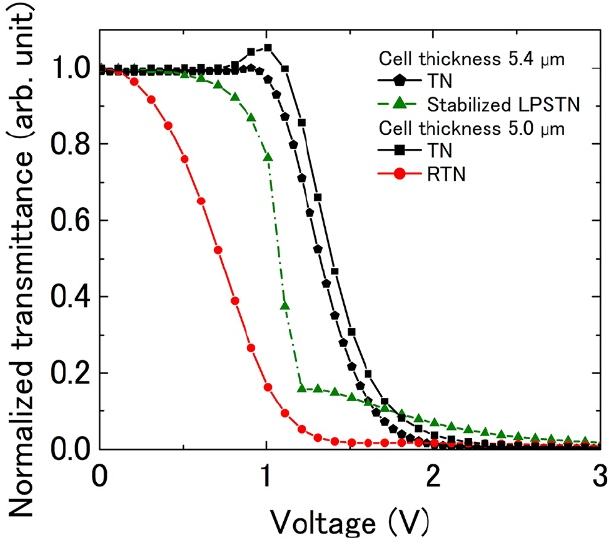
Figure 5. Transmittance as a function of applied voltage for TN (black solid pentagons, cell thickness of 5.4 µm), LPSTN (green solid triangles, chiral pitch of 15.0 µm, cell thickness of 5.0 µm, RM), TN (black solid squares, cell thickness of 5.0 µm), and RTN (red solid circles, chiral pitch of 15.0 µm, cell thickness of 5.0 µm, RM).